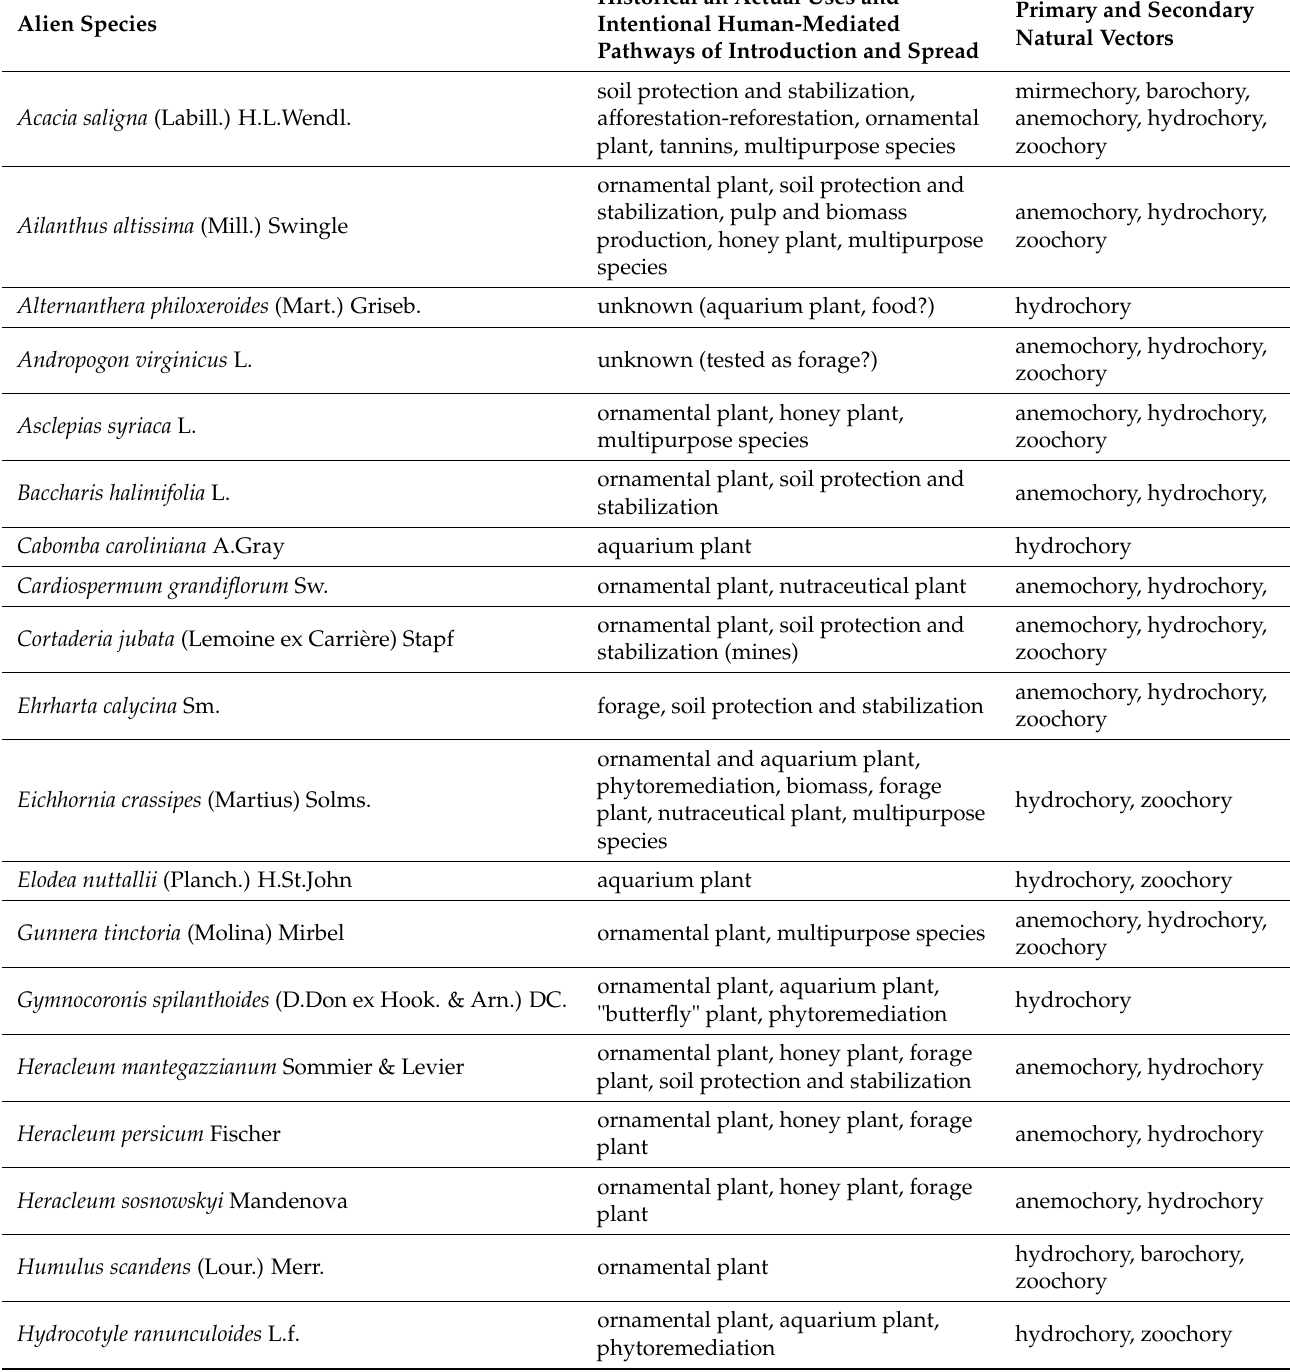
Table 4. Historical and actual uses and related intentional human-mediated pathways of introduction and spread of IAPUC and their natural